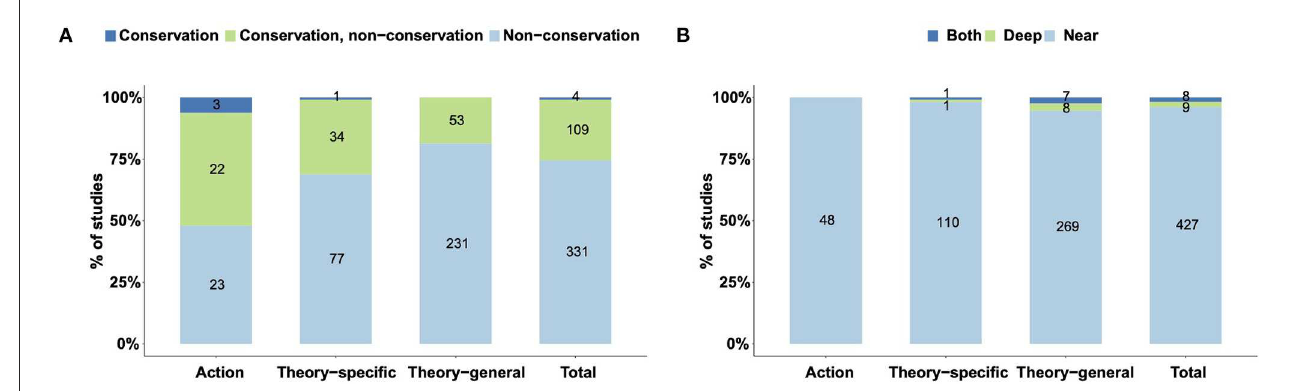
FIGURE2 Author affiliations among documented implementation categories. (A) Proportion of studies across the documented implementation categories (action, theory-specific, theory-general) coded as non-conservation, conservation, and a mix of conservation and non-conservation author affiliations. (B) Proportion of studies coded as near-time, deep-time, and a combination of both near- and deep-time. Numbers within bars equal sample size for each category.